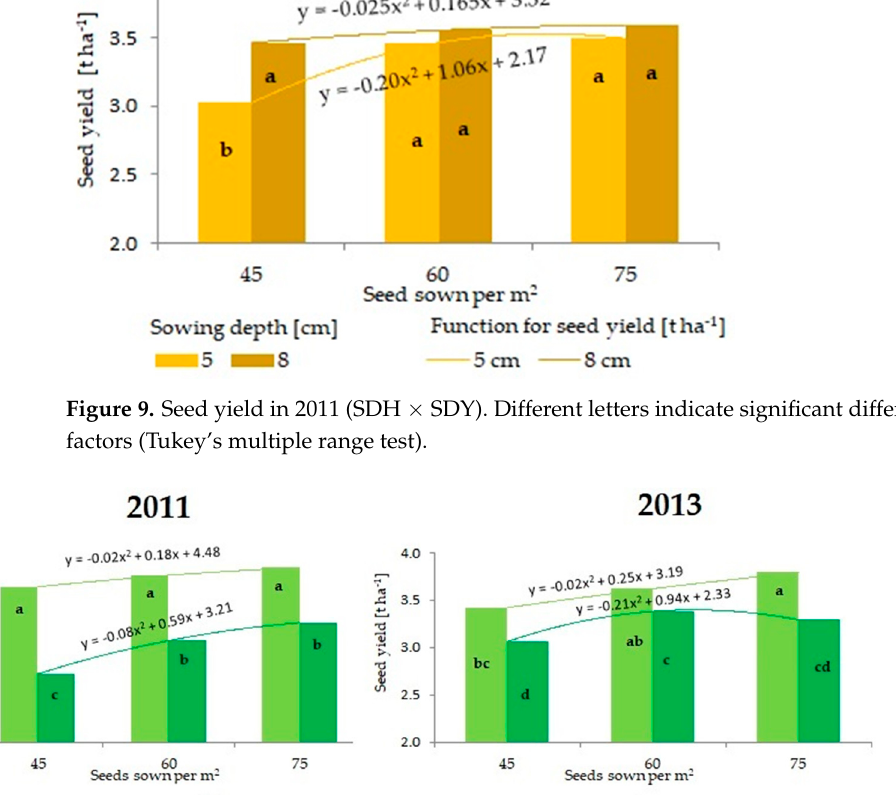
Figure 10. Seed yield in 2011 and 2013 (C × SDH). Different letters indicate significant differences between factors (Tukey’s multiple range test).